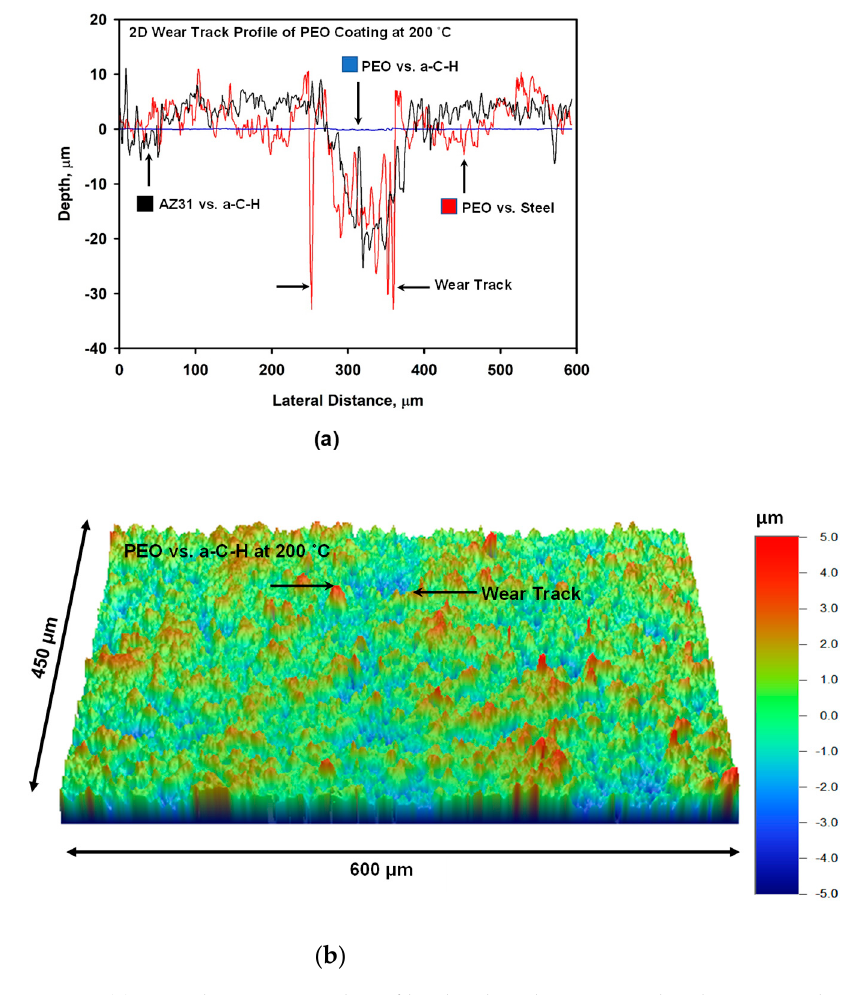
Figure 4. ( a ) Typical 2-D wear track profiles developed on uncoated and PEO coated AZ31 Mg contact surfaces running against 52100 steel at 200 ° C; ( b ) Typical 3-D profile of wear track developed on the surface of PEO running against a-C-H at 200 ° C. A 2-D profile of wear track is superimposed on 3-D profile.